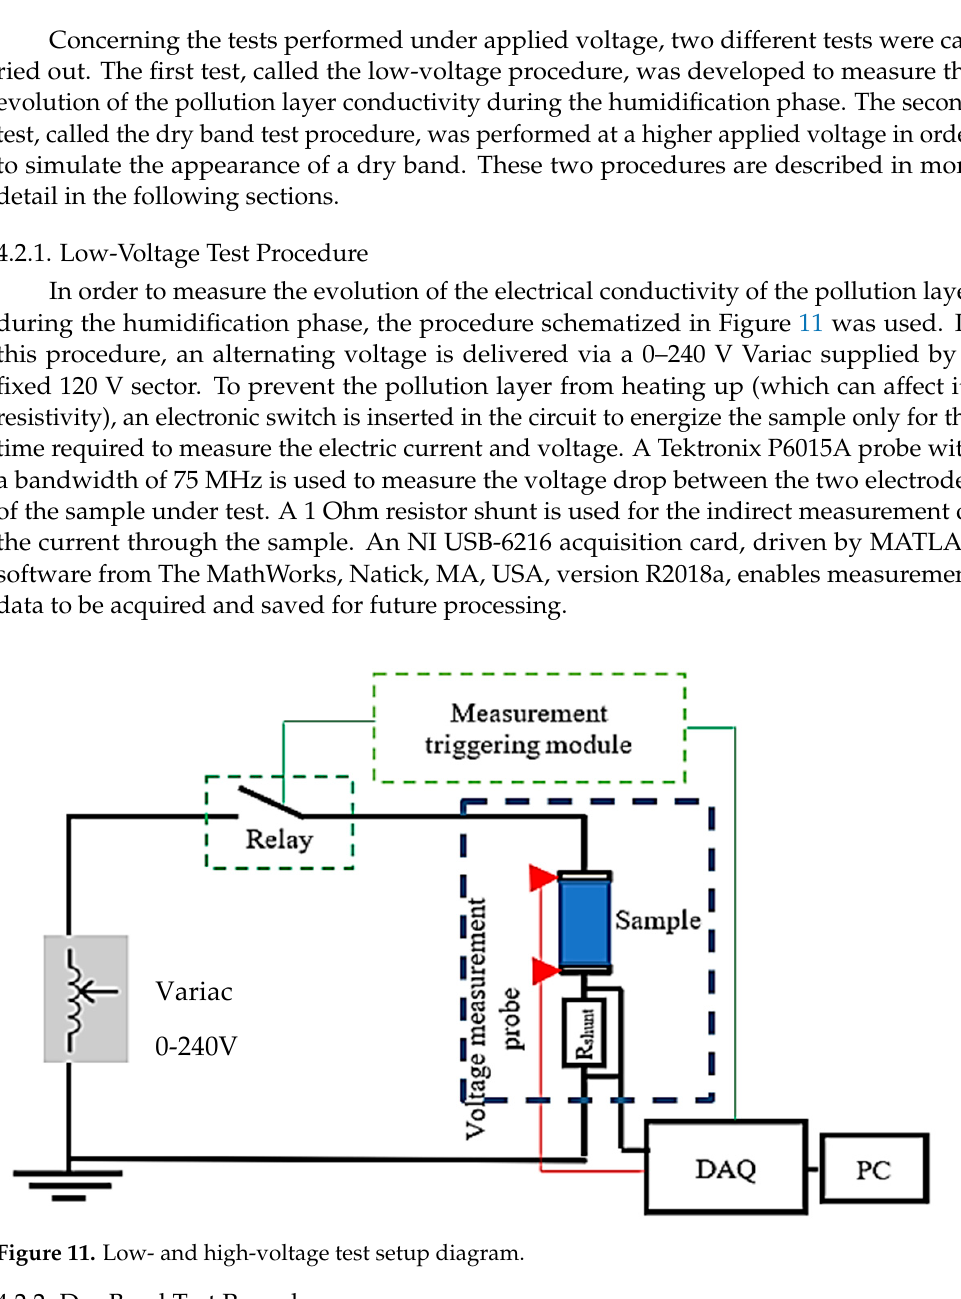
9 of 16 Figure 10. Climate chamber.